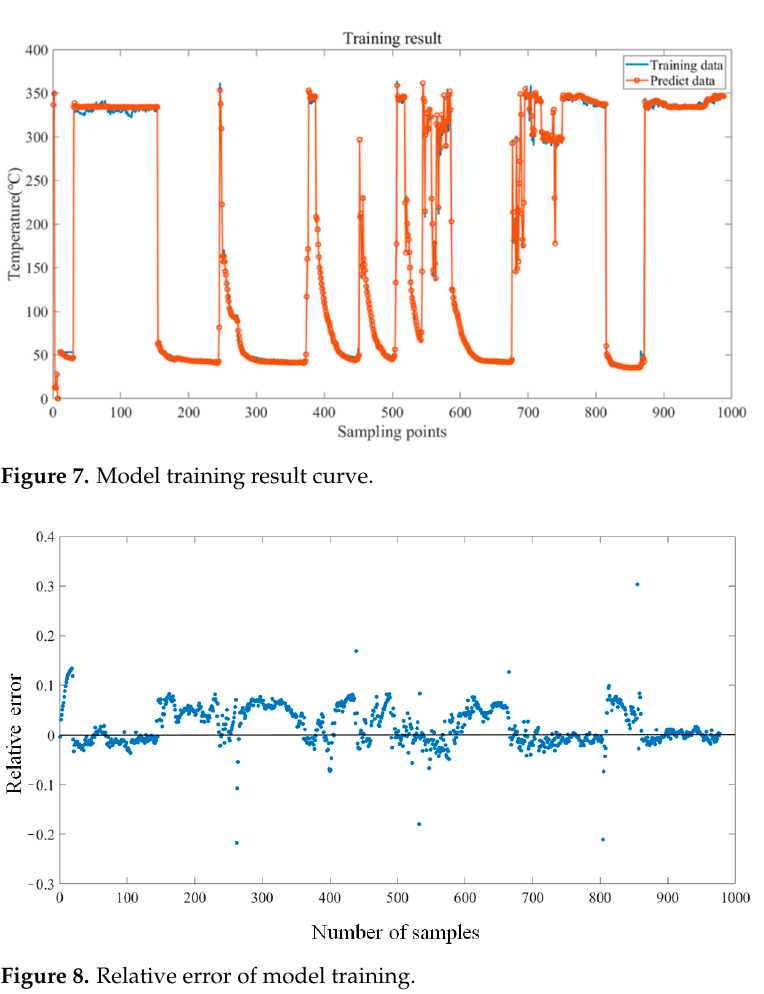
(d) Figure 11. The forecasting and actual temperature for different models: ( a ) Training and test re ‐ sults of AESR ‐ LSTM, ( b ) Training and test results of SR ‐ LSTM, ( c ) Training and test results of LSTM, and ( d ) Training and test results of BP.